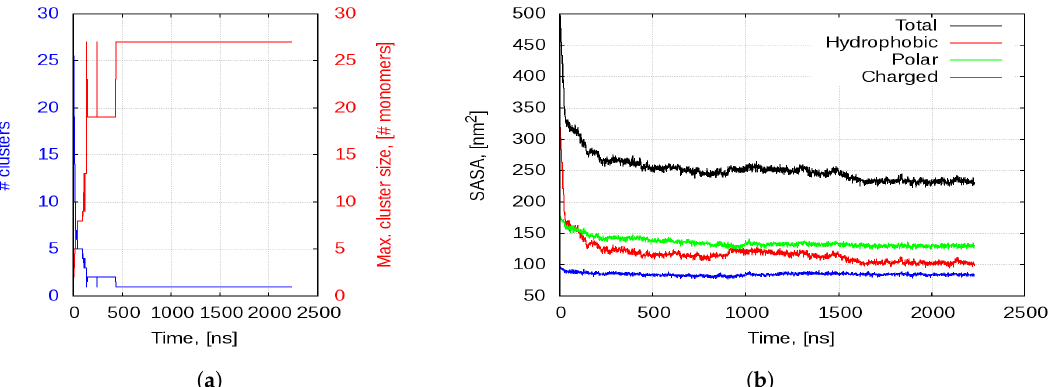
Figure 4. ( a ) Number of separate clusters/aggregates in the solution (blue curve) and maximal size of the clusters (red curve); and ( b ) SASA of all peptides in the solution.